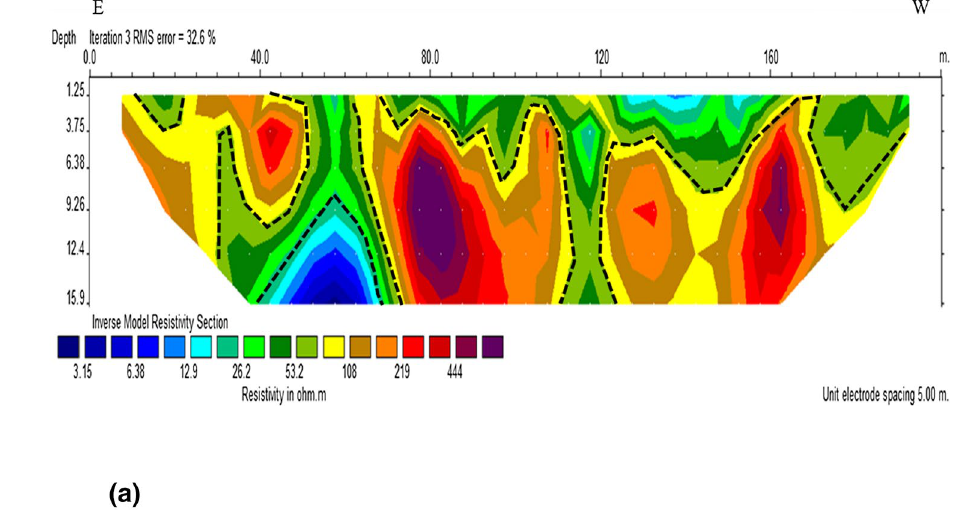
Fig. 8 VES curves, a K-type, b